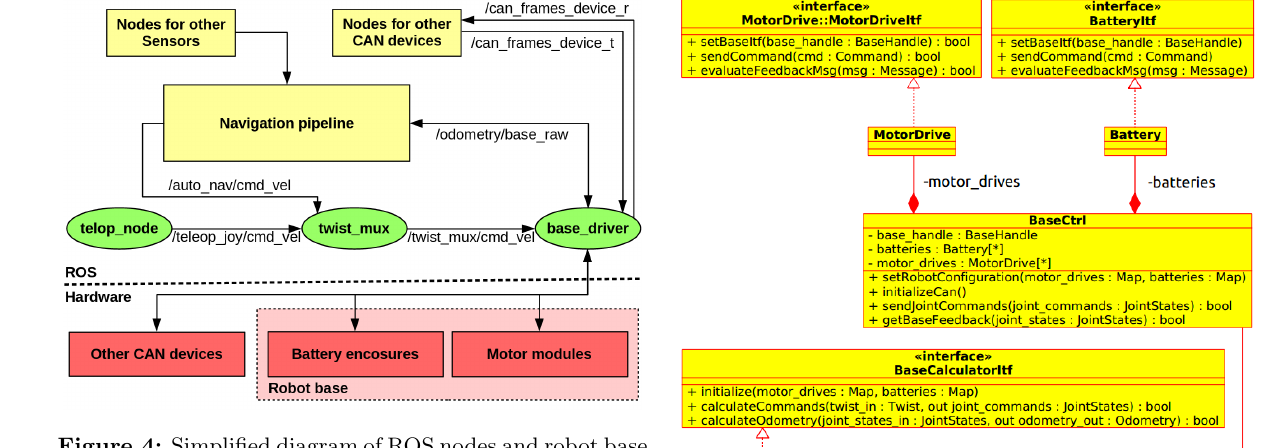
Figure 4: Simplified diagram of ROS nodes and robot base hardware